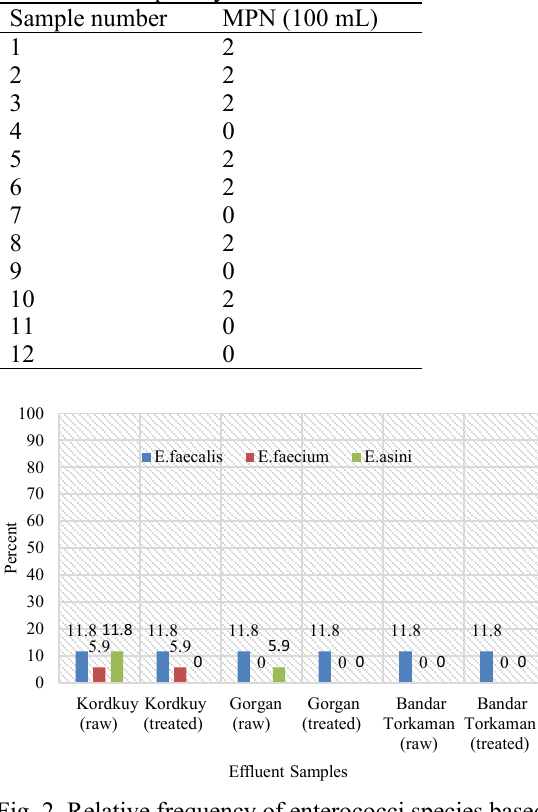
Fig. 2. Relative frequency of enterococci species